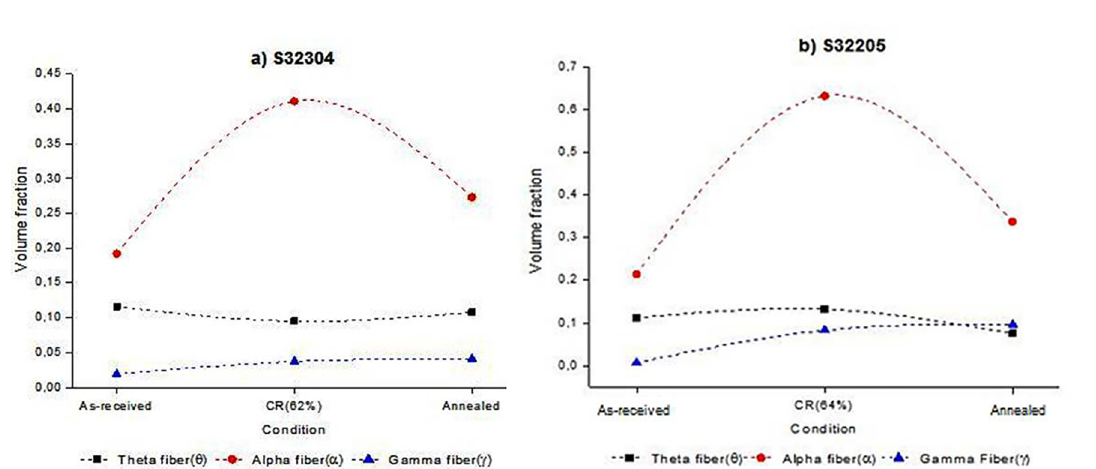
Figure 7. Volume fraction fiber of the phase ferritic of the duplex stainless steels: a) S32304 and b)